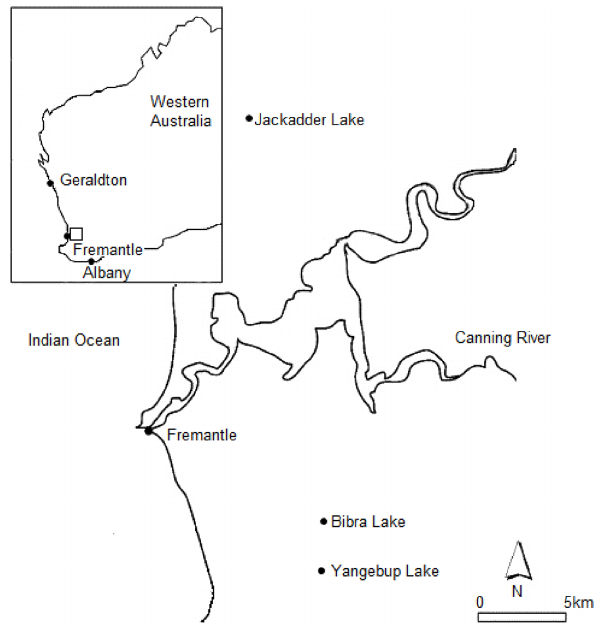
Figure 1. The locations of three studied lakes on Swan Coastal